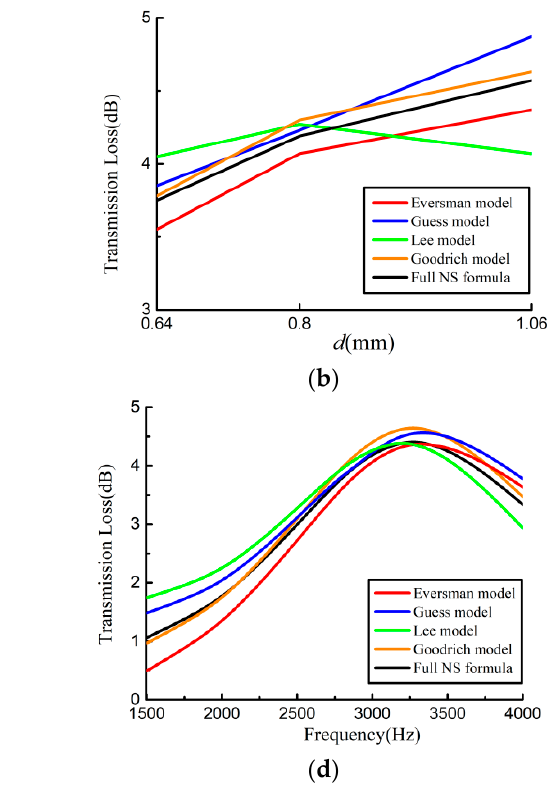
( b ) Figure 6. RDBRE system with grazing flow (suitable for the IBNSE method). ( a ) Geometric model. and ( b ) FE model.